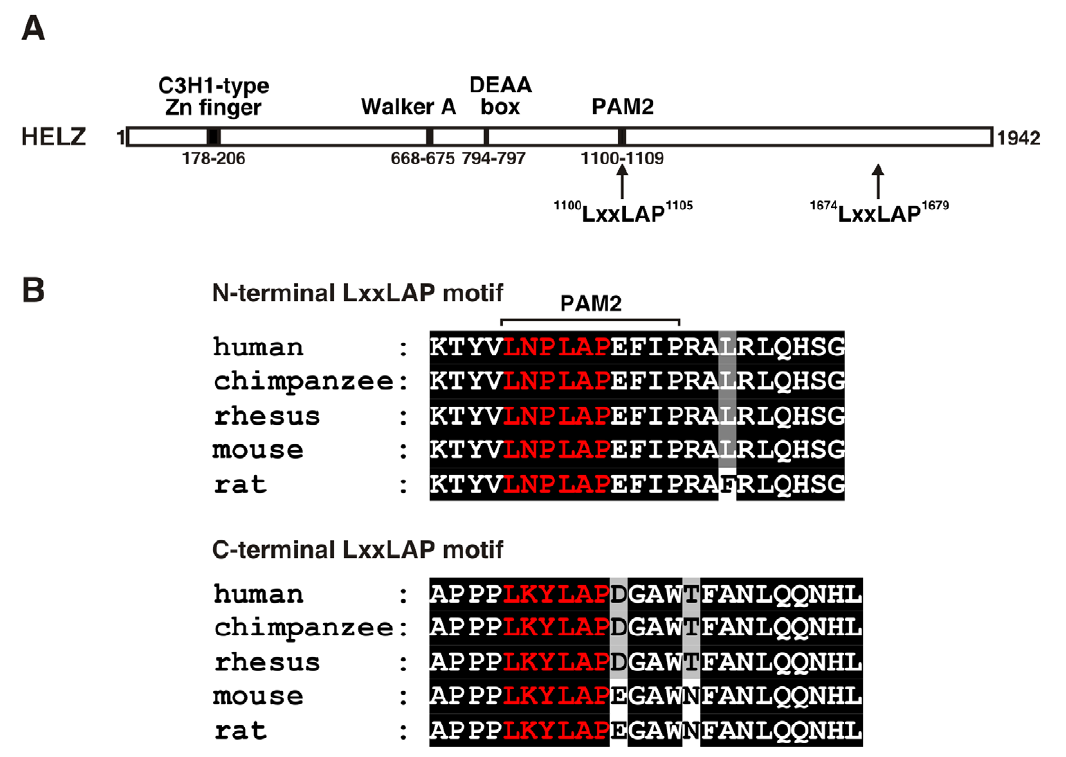
Figure 1. Human HELZ protein sequence analysis. ( A ) Schematic representation of the predicted human HELZ protein architecture. ( B ) Sequence alignment of the N-terminal LxxLAP motif that overlaps with the PAM2 motif (upper panel) and C-terminal LxxLAP motif (lower panel) of the indicated species. The LxxLAP motif is depicted in red and strictly conserved residues are shown as white letters on black background.